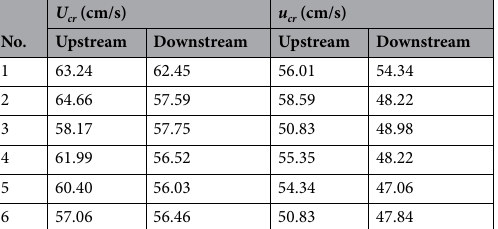
Table 6. Values of threshold velocities ( U cr and u cr ). Note: U cr = threshold average velocity; u cr = threshold near- bed